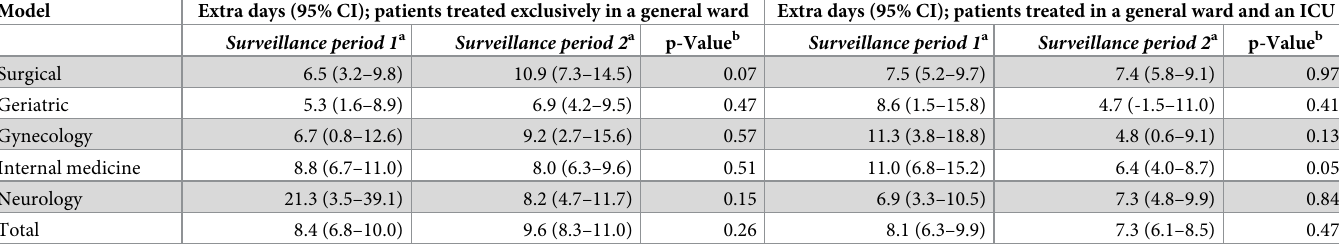
Table 3. Model approach 2: Extra days of hospitalization due to healthcare-associated infections stratified by department (rows), clinical unit stay of the patient and surveillance period (columns).